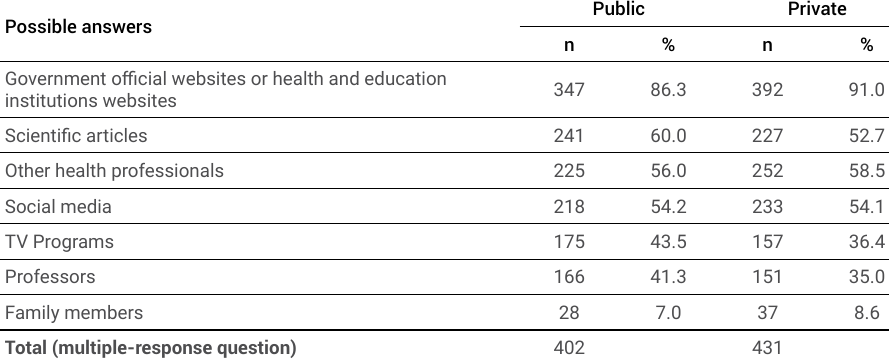
Table 2. Dental students’ source of information about COVID-19 by type of